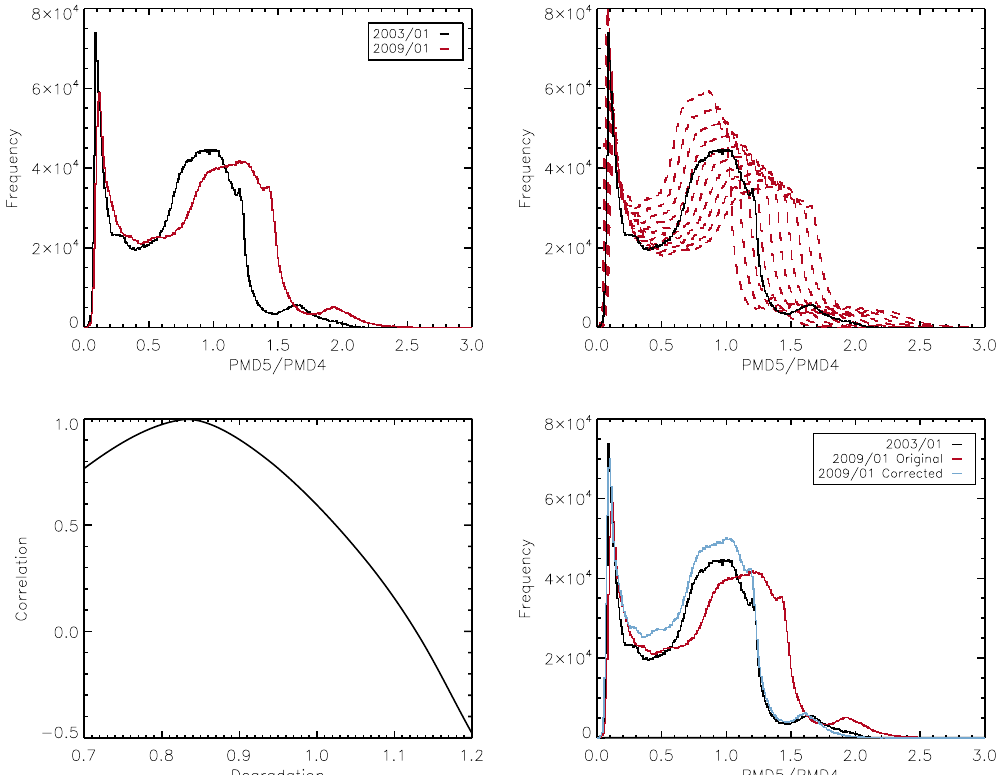
Fig. 4. The top-left panel shows the distribution profile of PMD 5/PMD 4 ratio as original in January 2003 (black), and the profile in January 2009 (red). It is clear that they have a similar profile with several maxima, apart from a shift. In the top-right panel the distribution of the PMD 5/PMD 4 ratio is again shown but now the January 2009 PMD 5/PMD 4 ratio has been multiplied with increasing degradation values, thus shifting the profile distribution. The bottom-left panel shows the correlation between the January 2009 and original January 2003 profile distribution, as a function of the applied degradation factor. From this panel the most likely (best correlated) degradation factor can be determined. The bottom-right panel repeats the upper-left panel, but now adds the degradation corrected profile for January 2009, showing the similarity in profiles. Repeating this method for each month allows determination of the degradation for the PMD 5/PMD 4